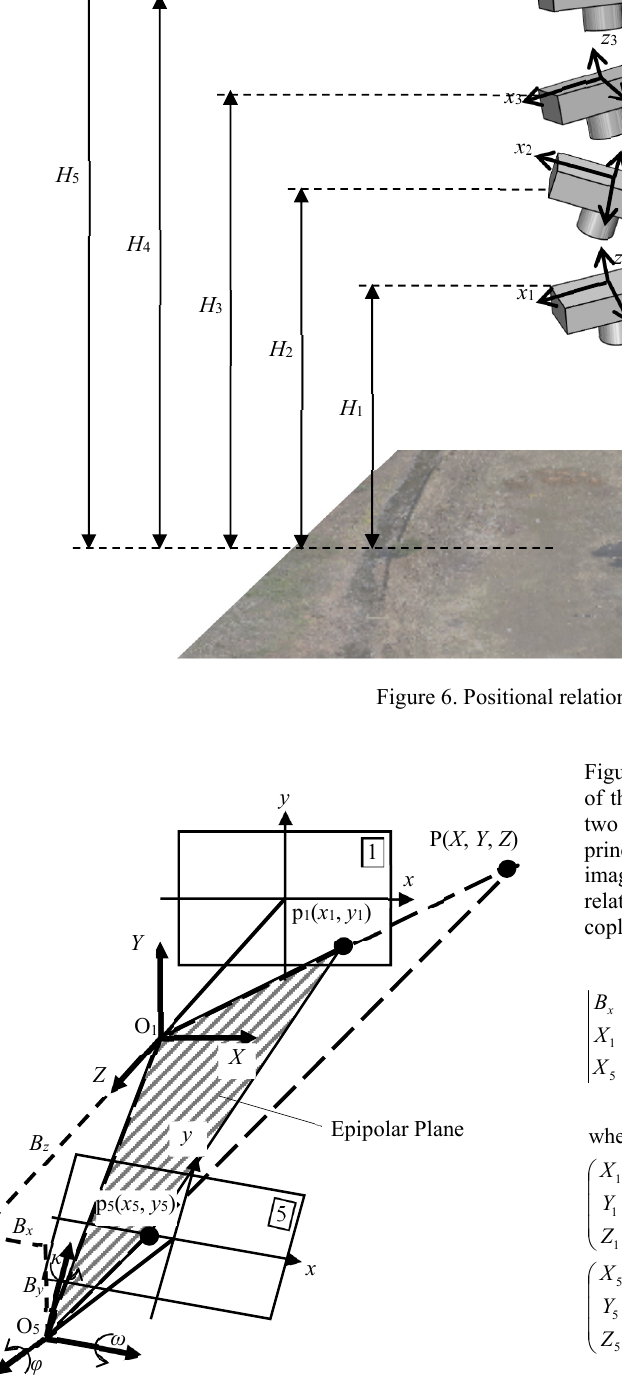
Figure 7. Coplanarity condition of two vertical images